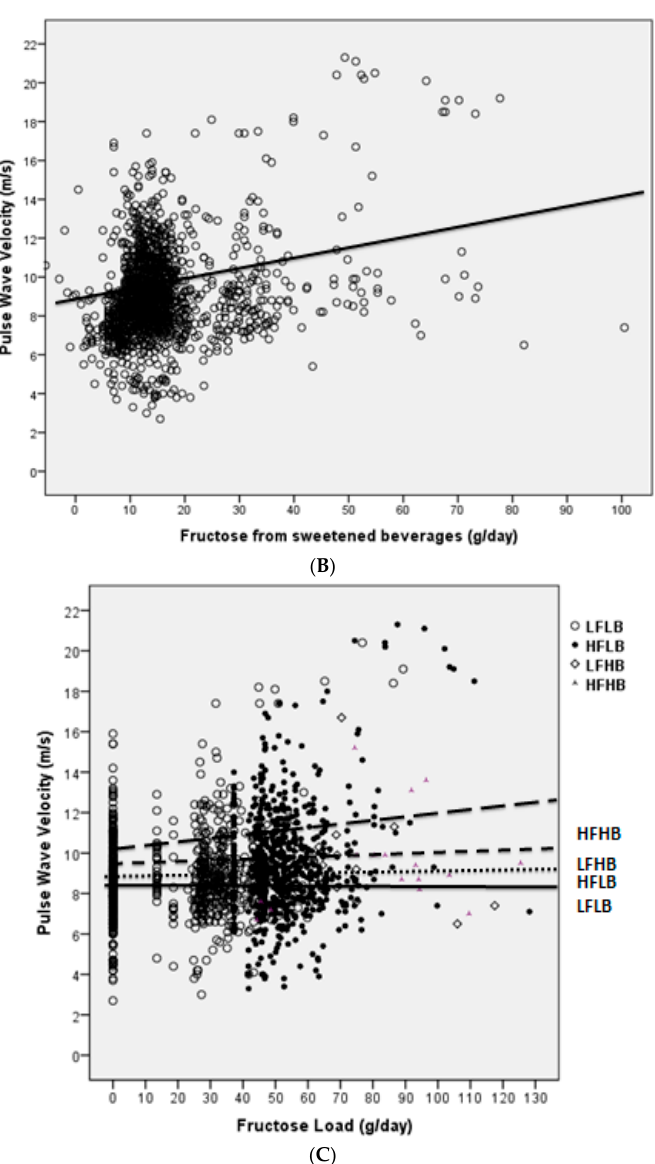
Figure 1. Regression graph plotting ( A ) cfPWV vs. fructose derived from fruits in the whole population sample, ( B ) cfPWV vs. fructose derived from sweetened beverages in the whole population sample and, ( C ) cfPWV vs fructose load in subjects consuming low fructose quantity, high fructose quantity from fruits, high fructose quantity by sugar-sweetened beverages or high fructose quantity from both sources.